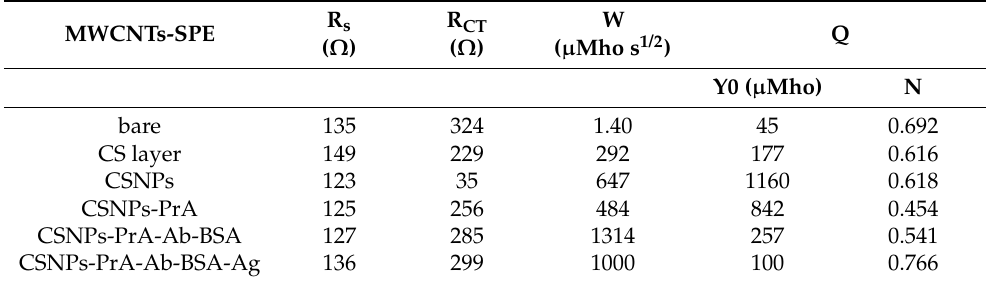
Table 1. Randles parameters for step-by-step development of D-dimer immunosensor.